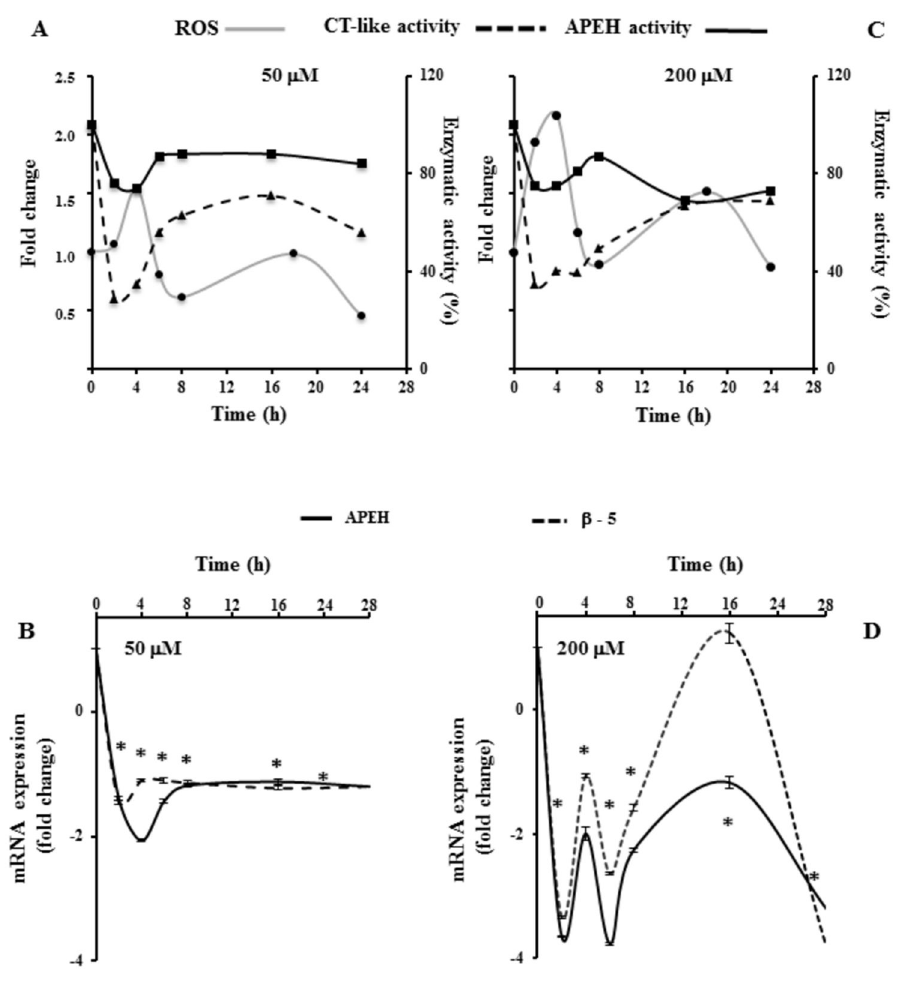
Figure 6. Time-dependent effects of t10,c12-CLA on APEH/proteasome system and on ROS production in A375 cells. Pre- confluent A375 cells were incubated with 50 μM or 200 μM of t10,c12-CLA for the indicated times. After treatments, cytoplasmic cell-extracts were used for the measurement of APEH and proteasomal CT-like activities (A,C). The ROS profiles were compared with the time courses of proteasomal CT-like and APEH activity levels (A,C). ROS production was assessed as described in materials and methods. cDNAs were synthesized and used for qRT-PCR amplification of APEH and β-5 (B,D) at the indicated times. The mRNA levels were finally expressed as fold change in comparison to untreated cells. Results were presented as means ±SD of triplicate data from three independent experiments and SD values lower than 5% were not shown. *Significantly different (P < 0.01) from respective